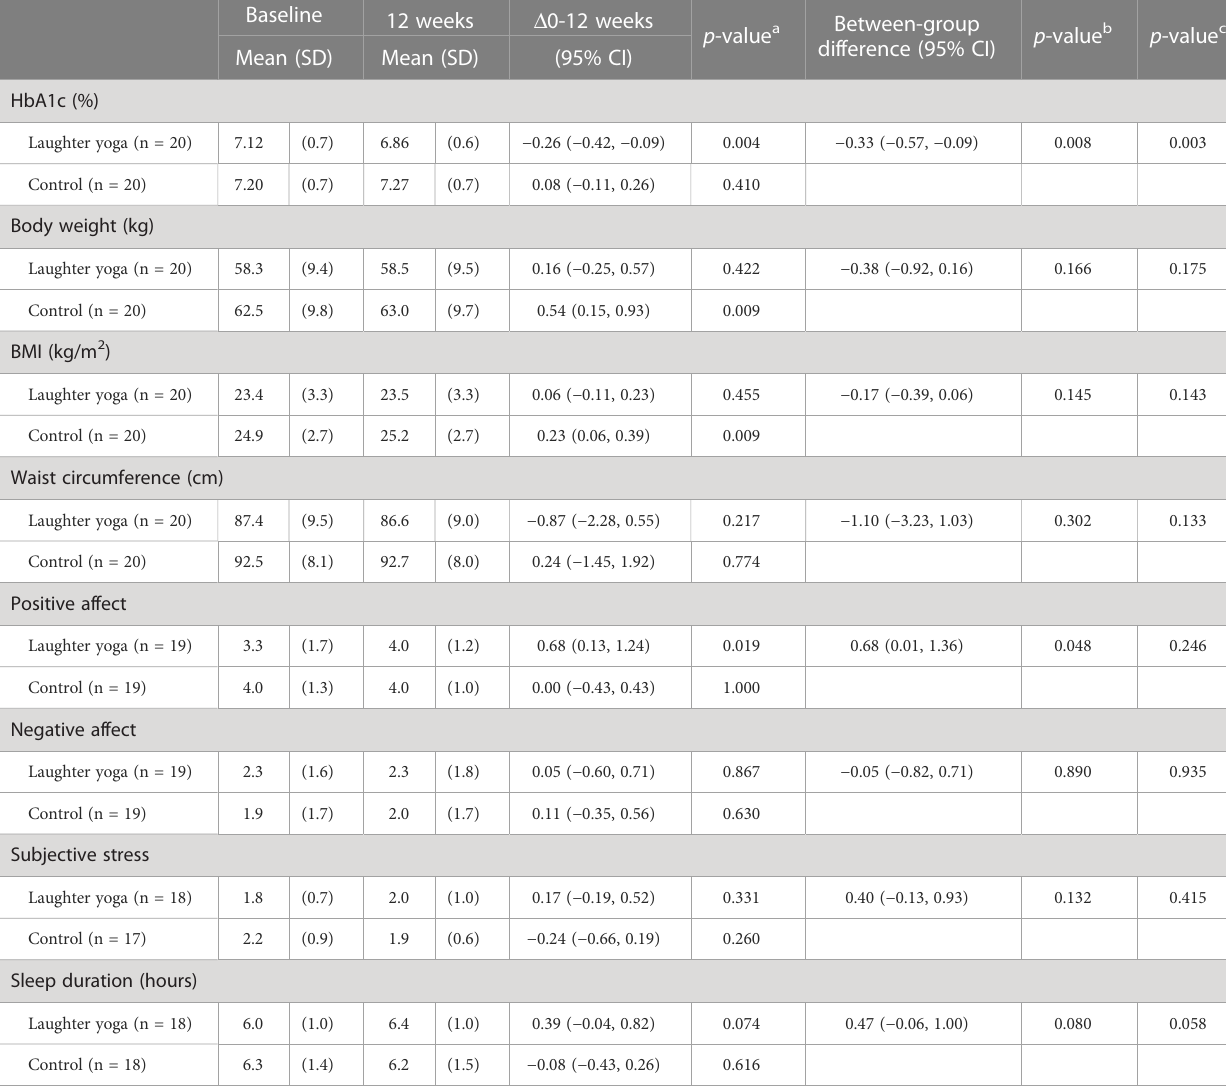
TABLE 3 Physiological and psychological changes during the intervention in the laughter yoga and control groups using per-protocol